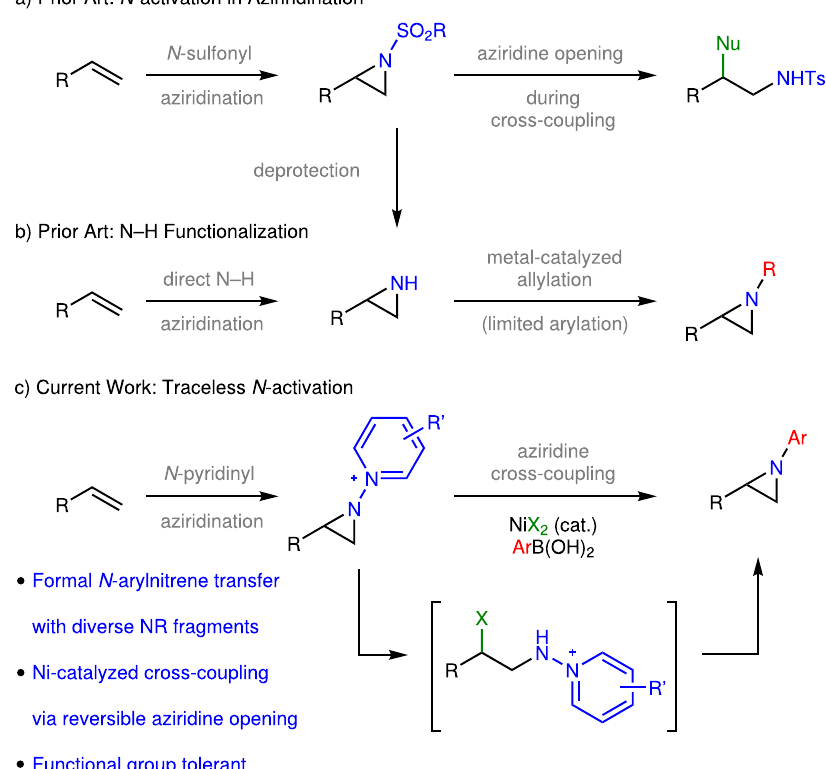
Fig. 1 N-Activation strategies for aziridination. a Nitrene transfer to ole fi ns provides access to aziridines but often requires the utilization of sulfonyl groups to activate the nitrogen. b N – H aziridines can be accessed directly from ole fi ns and metal-catalyzed allylation methods enable functionalization of the N – H valence. c Here we advance N -pyridinium aziridines as platforms for C – N cross coupling to provide access to N -substituted